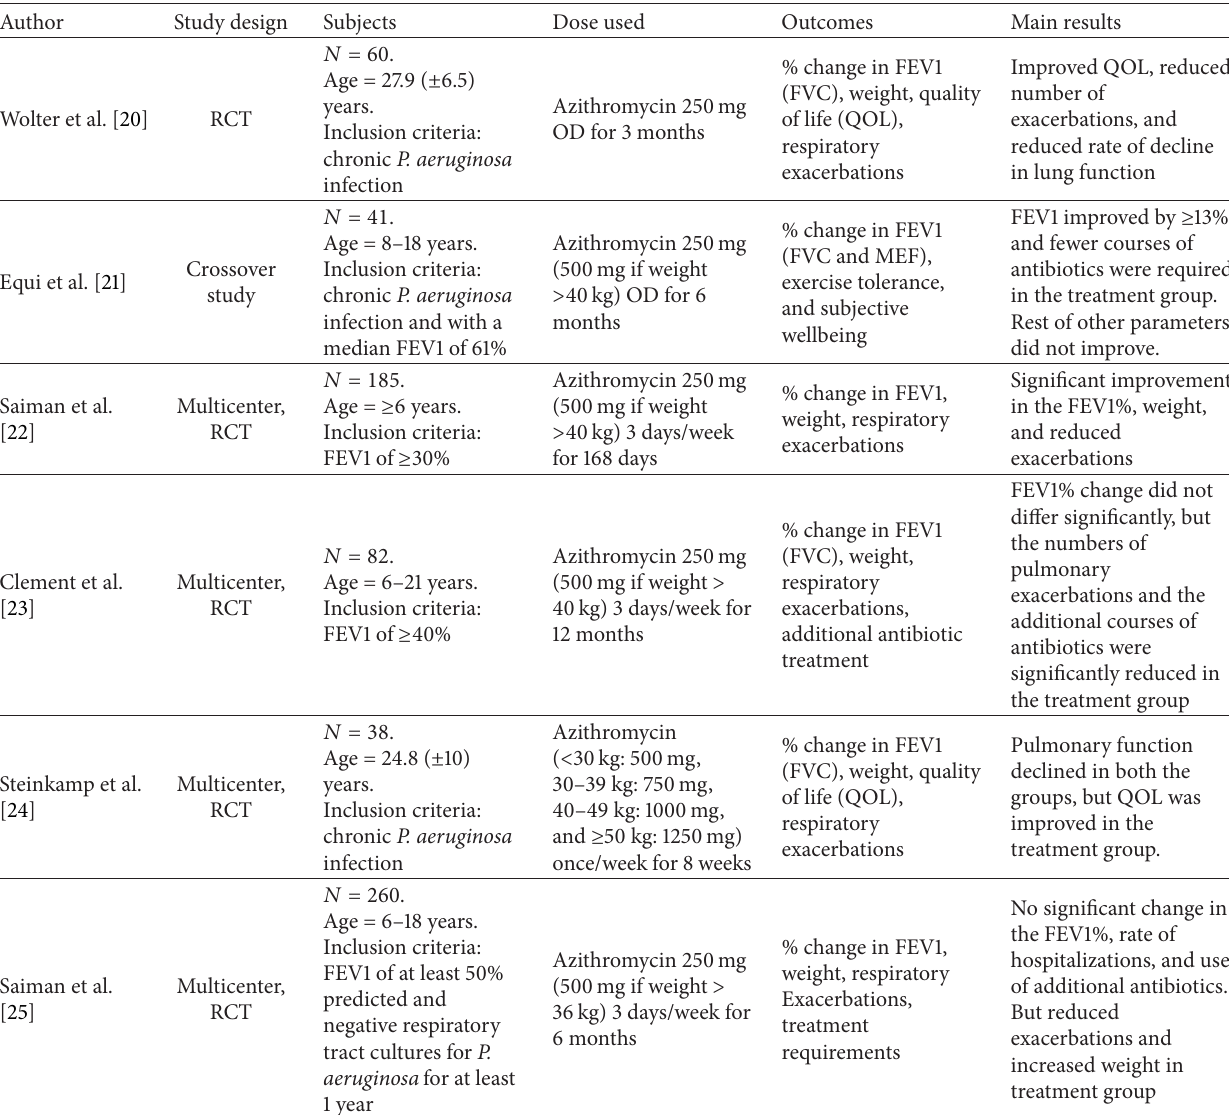
Table 4: Summary of azithromycin